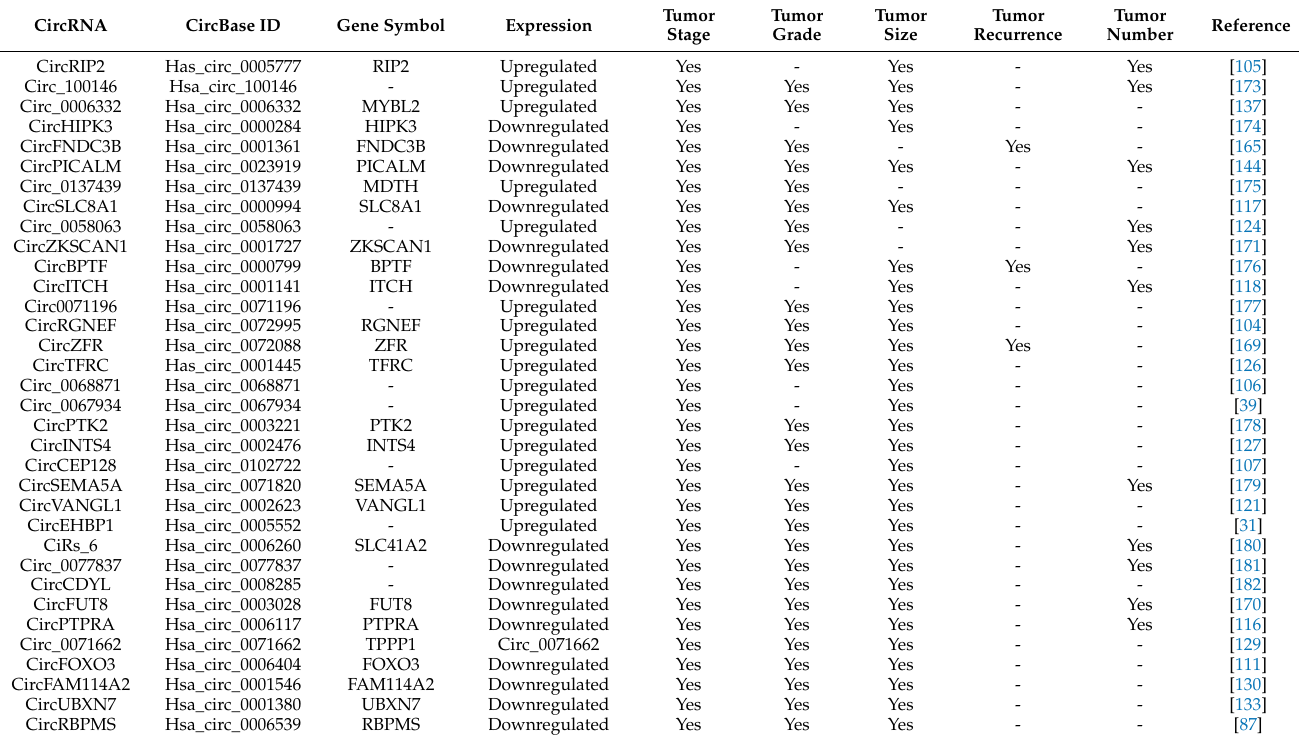
Table 4. Relationships between circRNAs quantities and clinicopathologic features in BC.